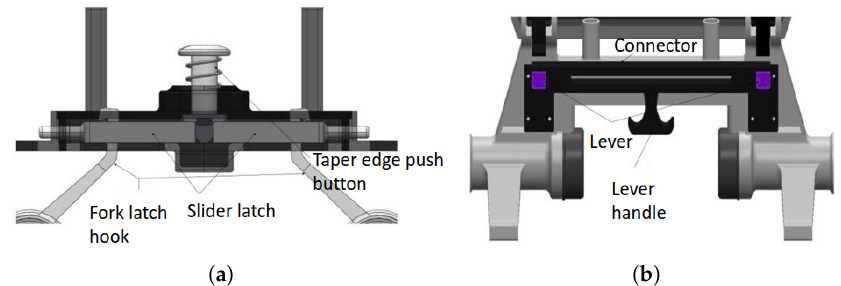
Figure 5. Three reconfiguration modes.